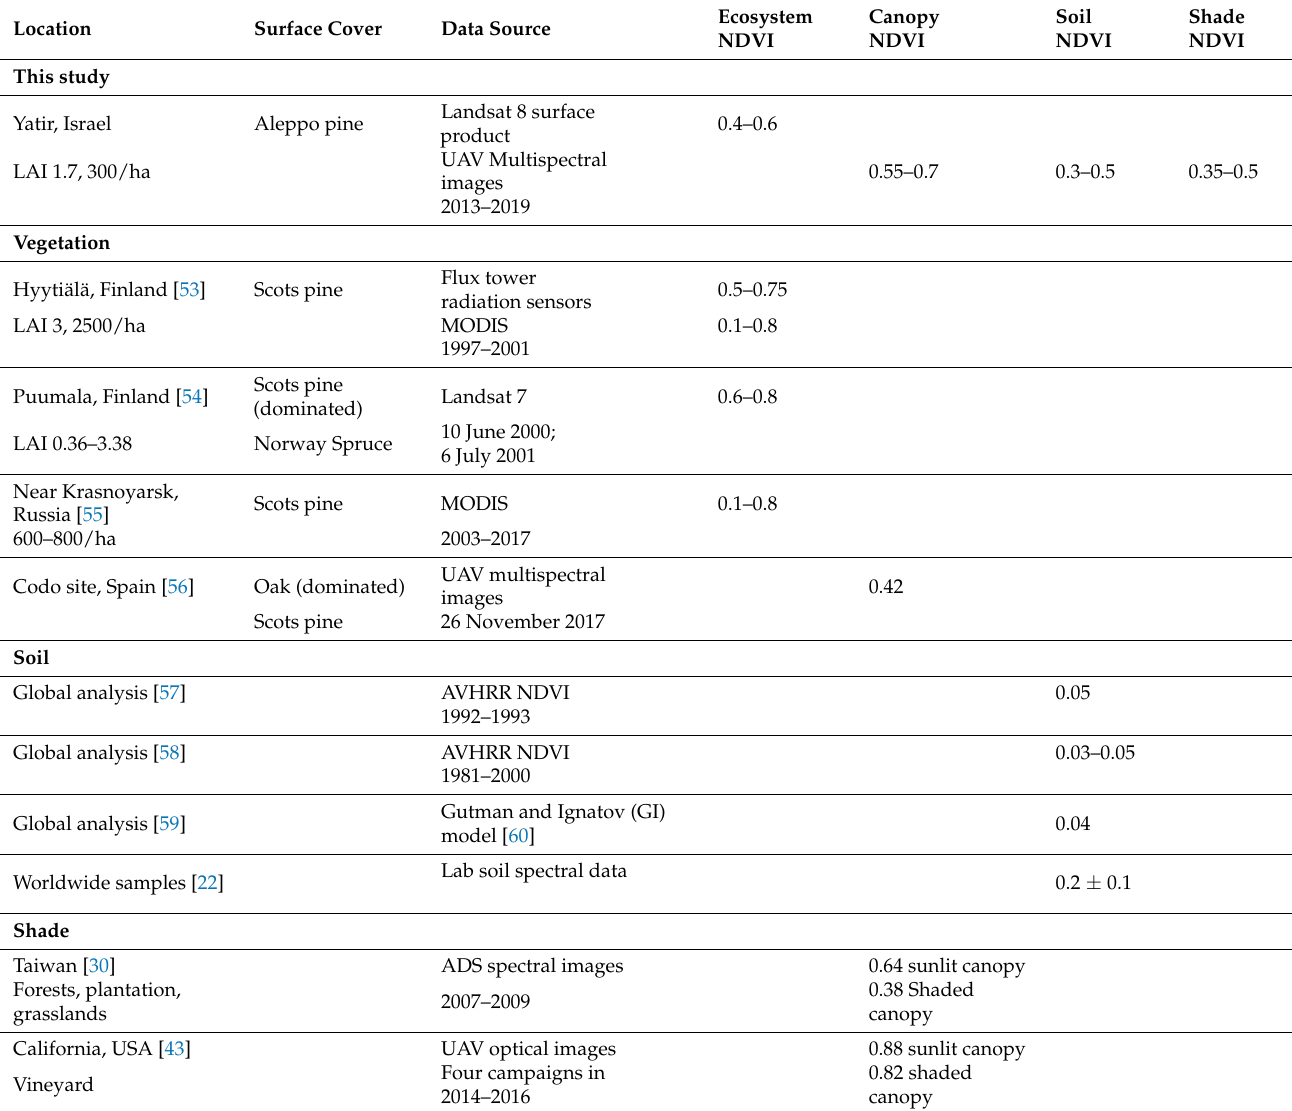
Table 1. Overviews of NDVI values (ranges) of pine canopy, soil, and shade in recent